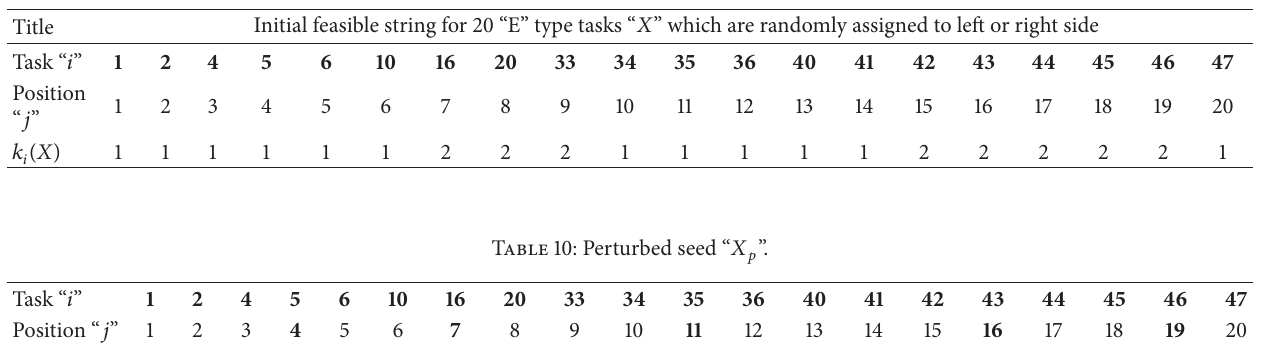
Table 9: Initial seed “ 𝑋 ” of the illustration problem P47.